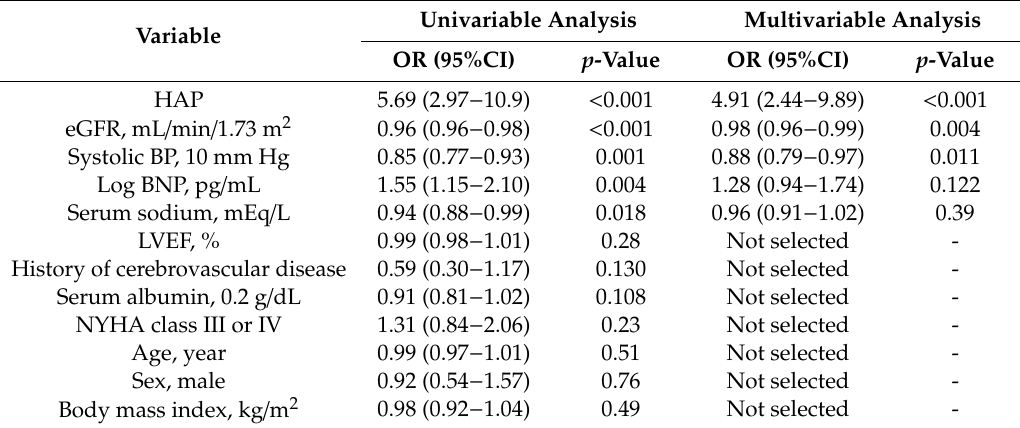
CI, confidence interval; OR, odds ratio. Other abbreviations as in Table 1. All data were obtained on admission.